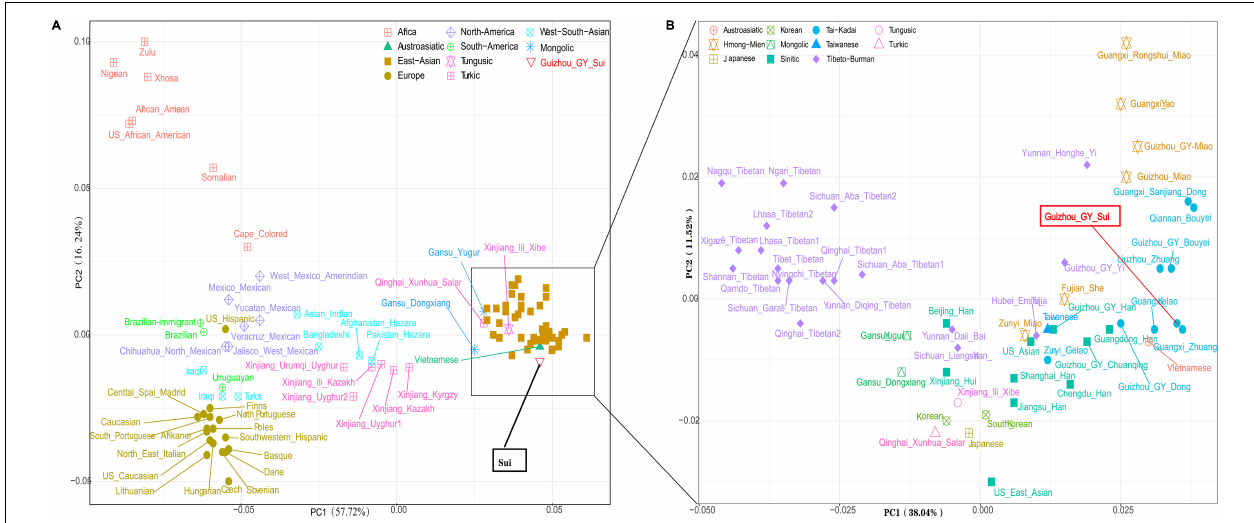
FIGURE 1 | The patterns of genetic relationship between Guizhou Sui and global reference populations based on the InDel low-density dataset. (A) The first two components of principal component analysis (PCA) results between the Guizhou Sui and 99 worldwide reference populations. (B) PCA-based East Asian populations showed the closer genetic Sui and other